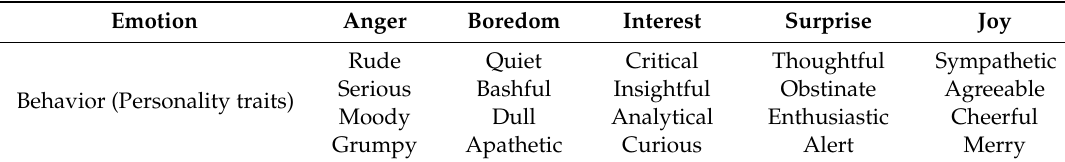
Table 8. Behaviors at Level 2.